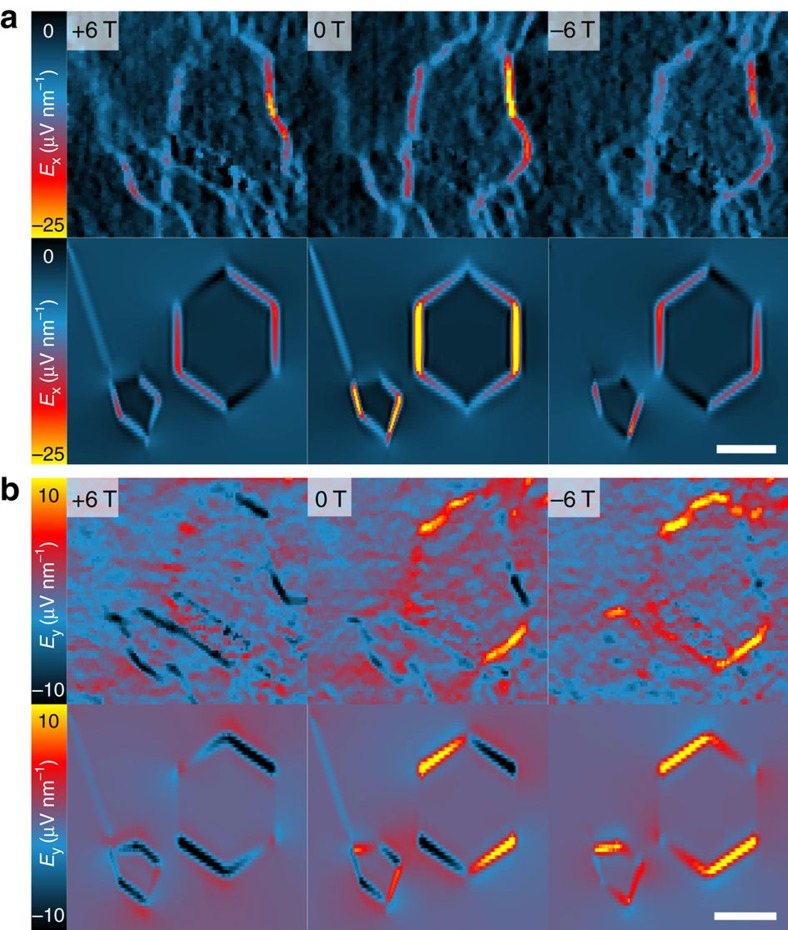
Local change of electric fields.(a) Electric field component Ex for the area surrounding the MLG island derived from the potential maps in Fig. 1e (−6 T/0 T/+6 T, area: 350 × 350 nm2). The lower row shows finite-element method simulations (see Supplementary Note 5) of the area with simple geometries for the ML/BL interfaces and the wrinkle on the left. (b) Analysis of the electric field component Ey analogous to a.